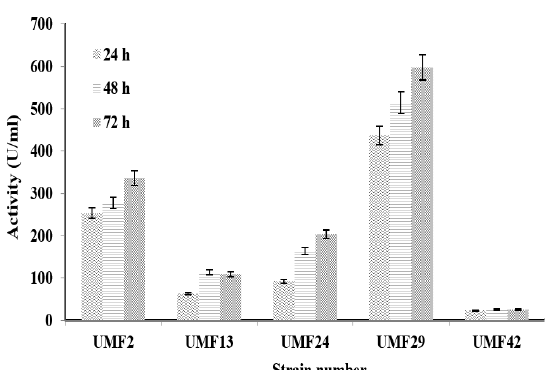
Fig. 3. Effect of incubation time on the alpha-amylase production of the five isolated strains: UMF2, UMF13, UMF24, UMF29, and UMF42. Enzyme samples were retrieved every 24 h to 72